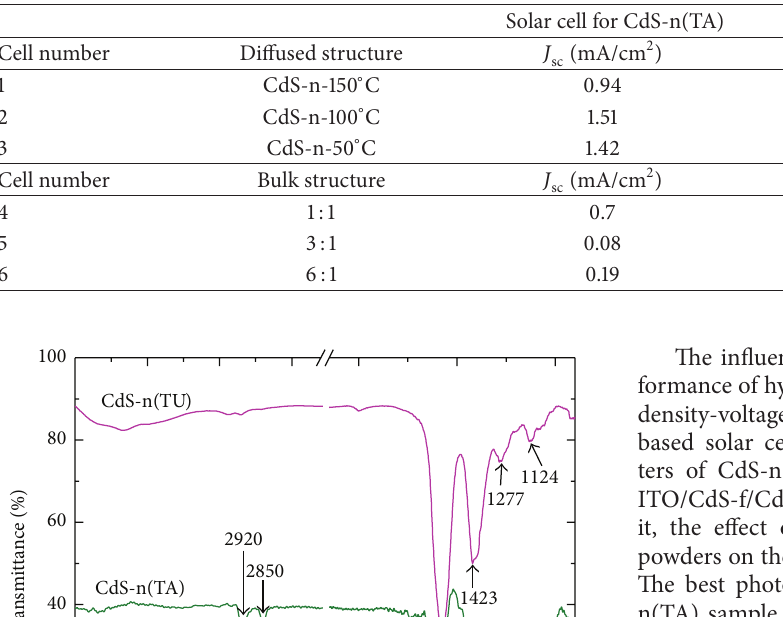
Table 2: Photocurrent density at short circuit ( 𝐽 of hybrid solar cells with CdS-n(TA) with diffused structure: ITO/CdS-f/CdS-n(TA)/P3HT/CP/Au and bulk structure: ITO/CdS-f/CdS- n(TA):P3HT/CP/Au.